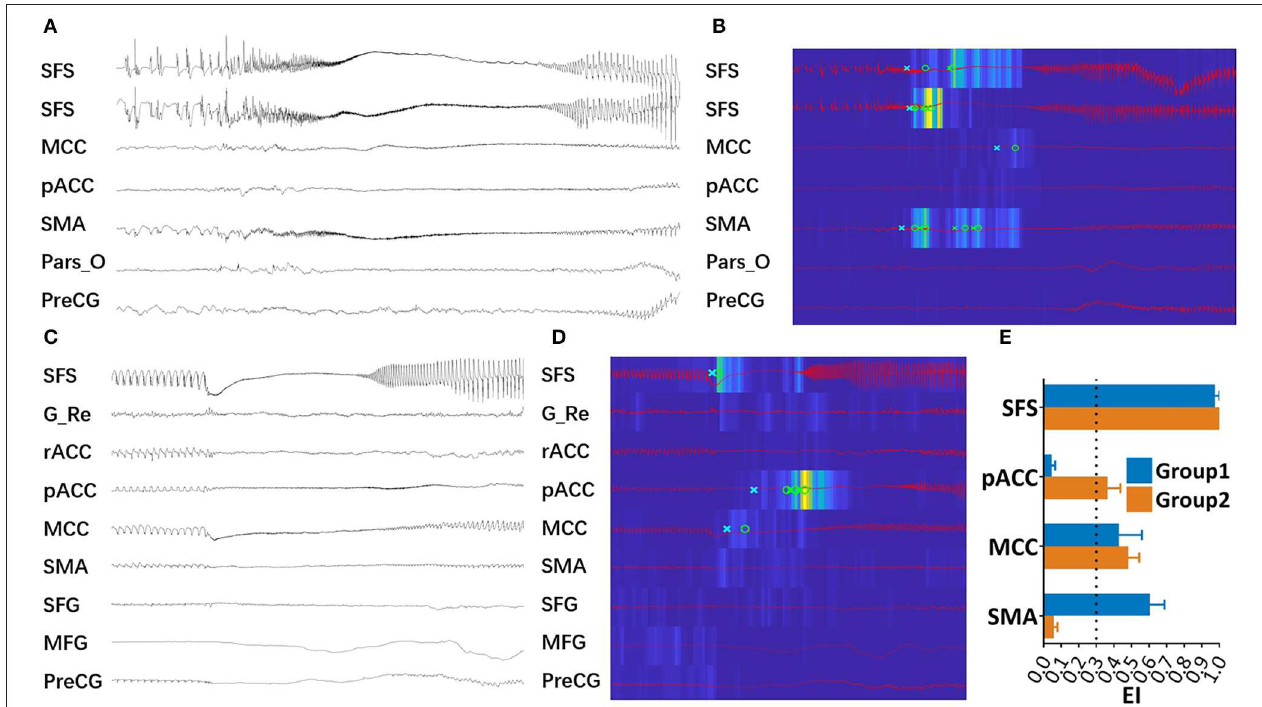
FIGURE 3 | High epileptogenic structures in 2 groups. (A) SEEG recording of one seizure of Case 3 in group 1. (B) EI values of the same seizure event presents an increased energy ratio at the ictal onset (from blue to yellow scale) and the detection parameters (circle, alarm time; cross, detection time) in each channel. This map showed that SFS, SMA, and MCC were highly epileptogenic. (C) SEEG recording of one seizure of Case 13 in group 2. (D) EI values map of the same seizure attack, in which SFS, MCC, and pACC were highly epileptogenic. (E) Mean EI value of the SFS, pACC, MCC, and SMA in each group. The arbitrary cut-off value used to identify the extended EZ was set at 0.3, as previously described ( 18). (G_Re, gyrus rectus; MFG, middle frontal gyrus; Pars_O, pars opercularis; PreCG, pre-central gyrus, rACC, rostral anterior cingulate cortex, SFG, superior frontal